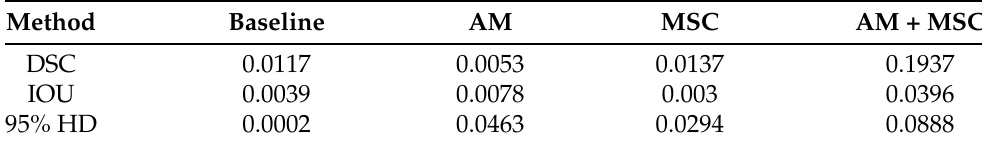
Figure 9. The box plots of metrics of ablation study. ( a ) DSC coefficient comparison; ( b ) IOU coefficient comparison; ( c ) 95% HD coefficient comparison. * indicates a significant difference between the corresponding experiments, with *** p ≤ 0.001, ** p ≤ 0.01, * p ≤ 0.05, and ns p ≤ 1 (paired t -test). Table 4. p value of different